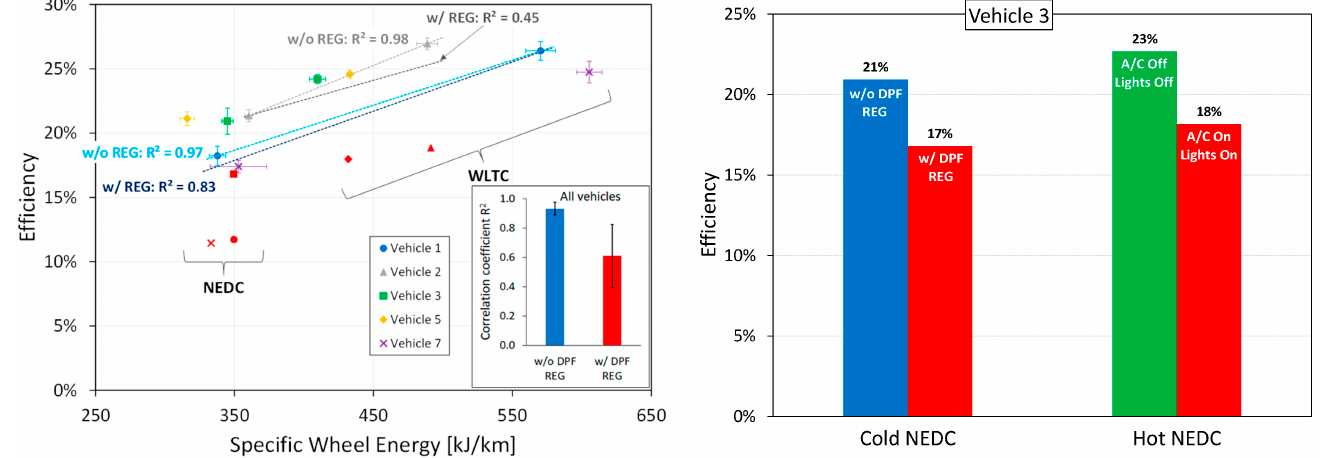
Figure 13. Efficiency versus specific wheel energy ( left ) and impact of other energy consump- tions ( right